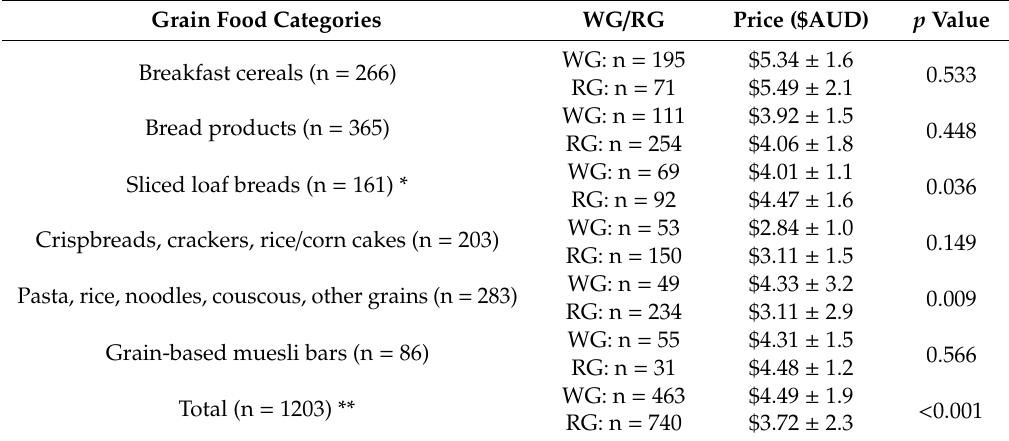
Table 3. Price comparison of whole grain (WG) and refined grain (RG)